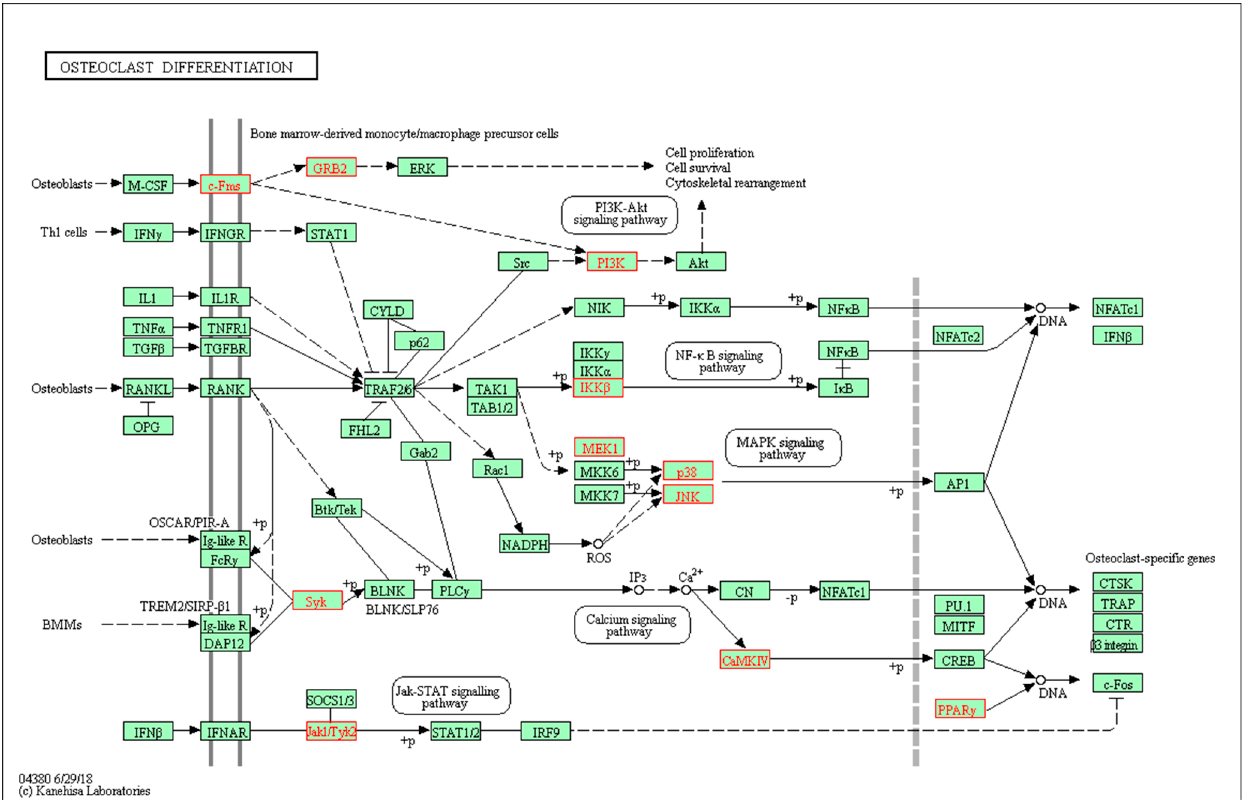
Figure 8. Osteoclast differentiation pathway obtained through KEGG enrichment analysis of co- targets of GCK–osteoporosis (all of the enriched targets are marked in red).